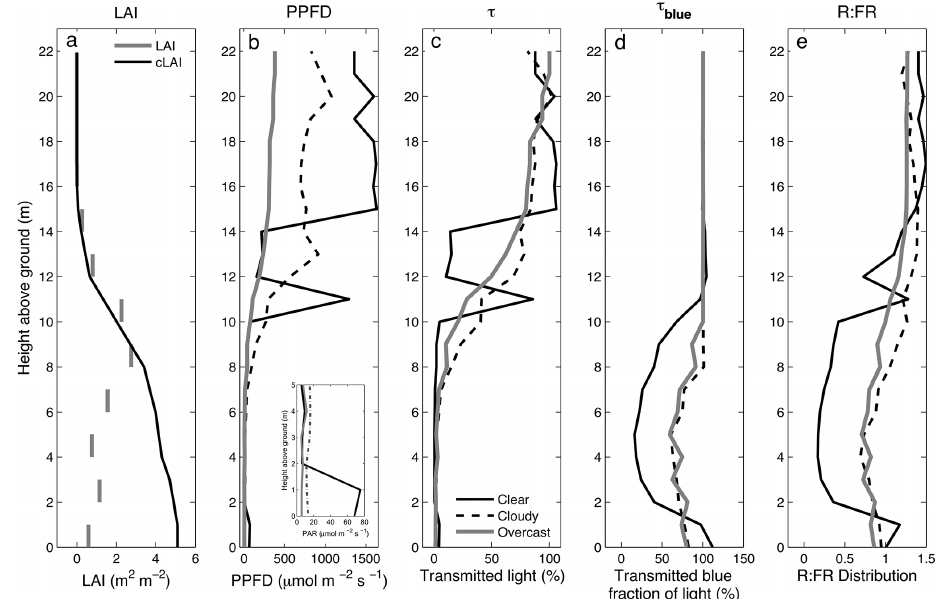
Figure 5. (a) vertical distribution of leaf area index (LAI) and cumulative leaf area index (cLAI); (b) vertical distribution of photosynthetic flux density (PPFD) on a clear day (black line), cloudy day (pecked black line), overcast day (grey line). The insert is a magnification of the lowest 5m above the forest floor, showing the forest floor illumination caused by sunflecks; (c) the same as (b) but normalised as transmissivity; (d) transmissivity of blue light; (e) vertical profile of the red:far-red ratio (R:FR).